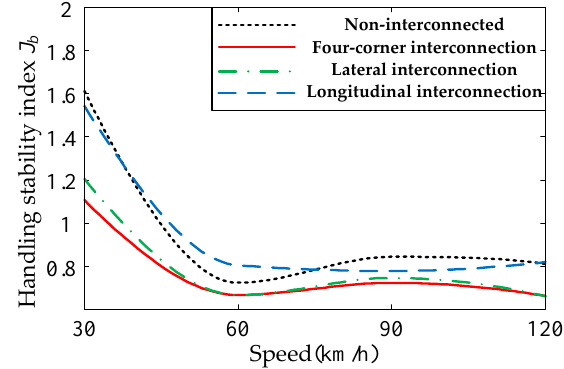
Figure 5. Handling stability index J b under the straight condition.